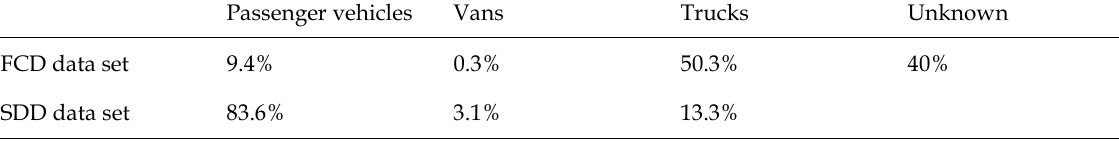
Vehicle classification